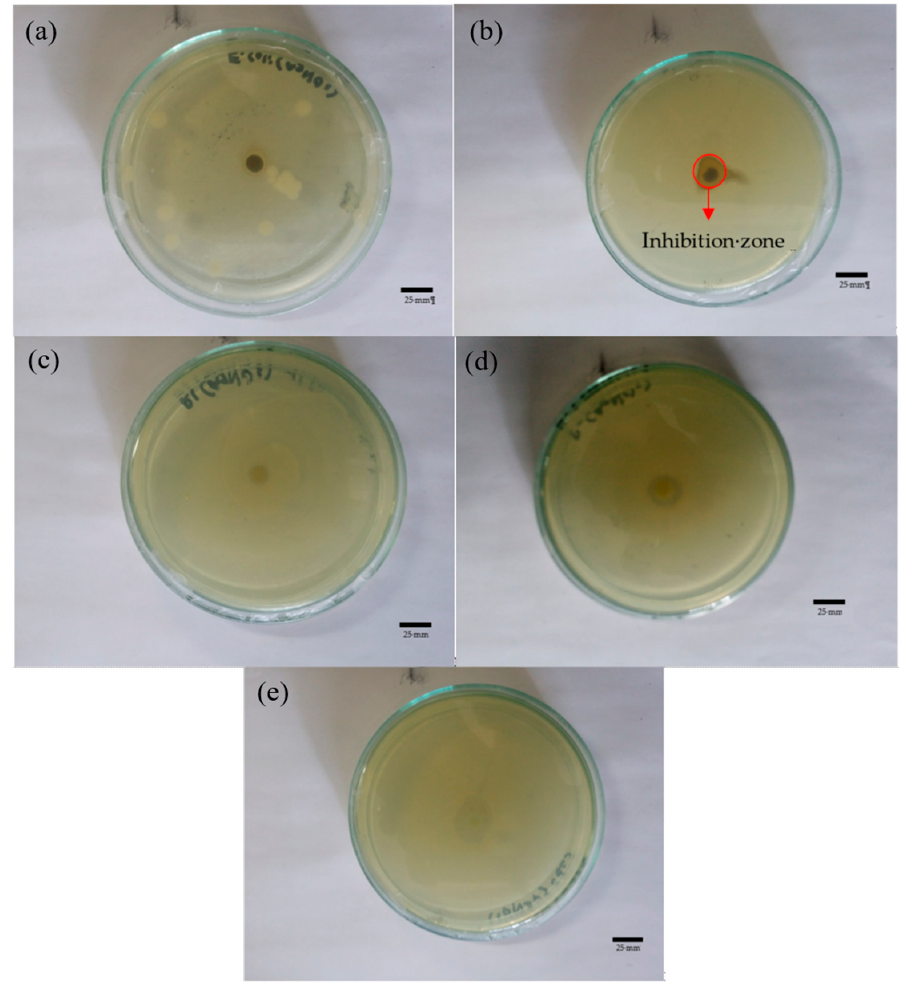
Figure 7. Zone of inhibition of Cyperus rotundus against ( a ) E. coli ; ( b ) B. cereus ; ( c ) C. haemolyticum UDIN2; ( d ) C. haemolyticum UDIN3; and ( e ) C. haemolyticum UDIN1. The scale bar is 25 mm.